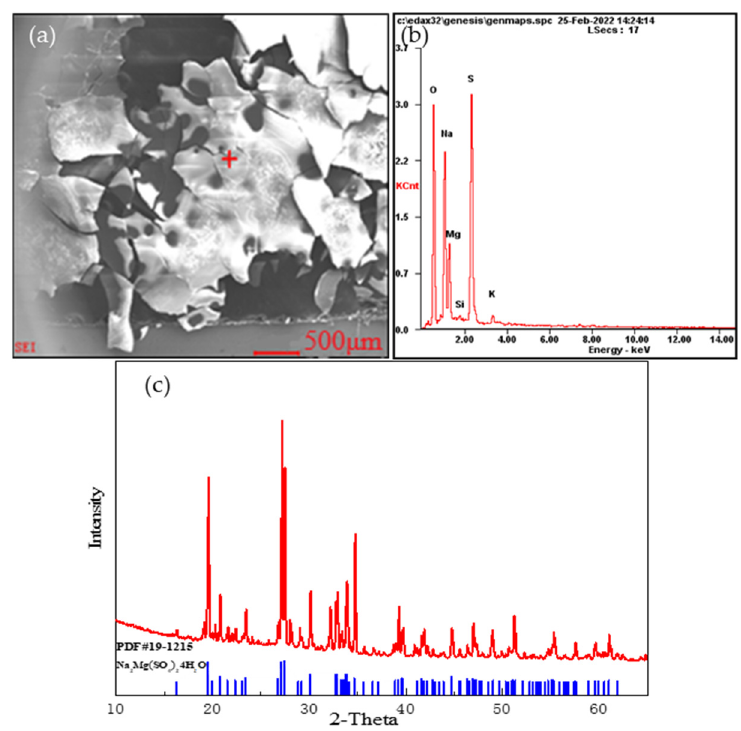
Figure 9. Soluble minerals: ( a ) Scanning electron microscope image of the soluble minerals; ( b ) EDS analysis at “+” position; ( c ) X-ray diffraction analysis of the soluble minerals.